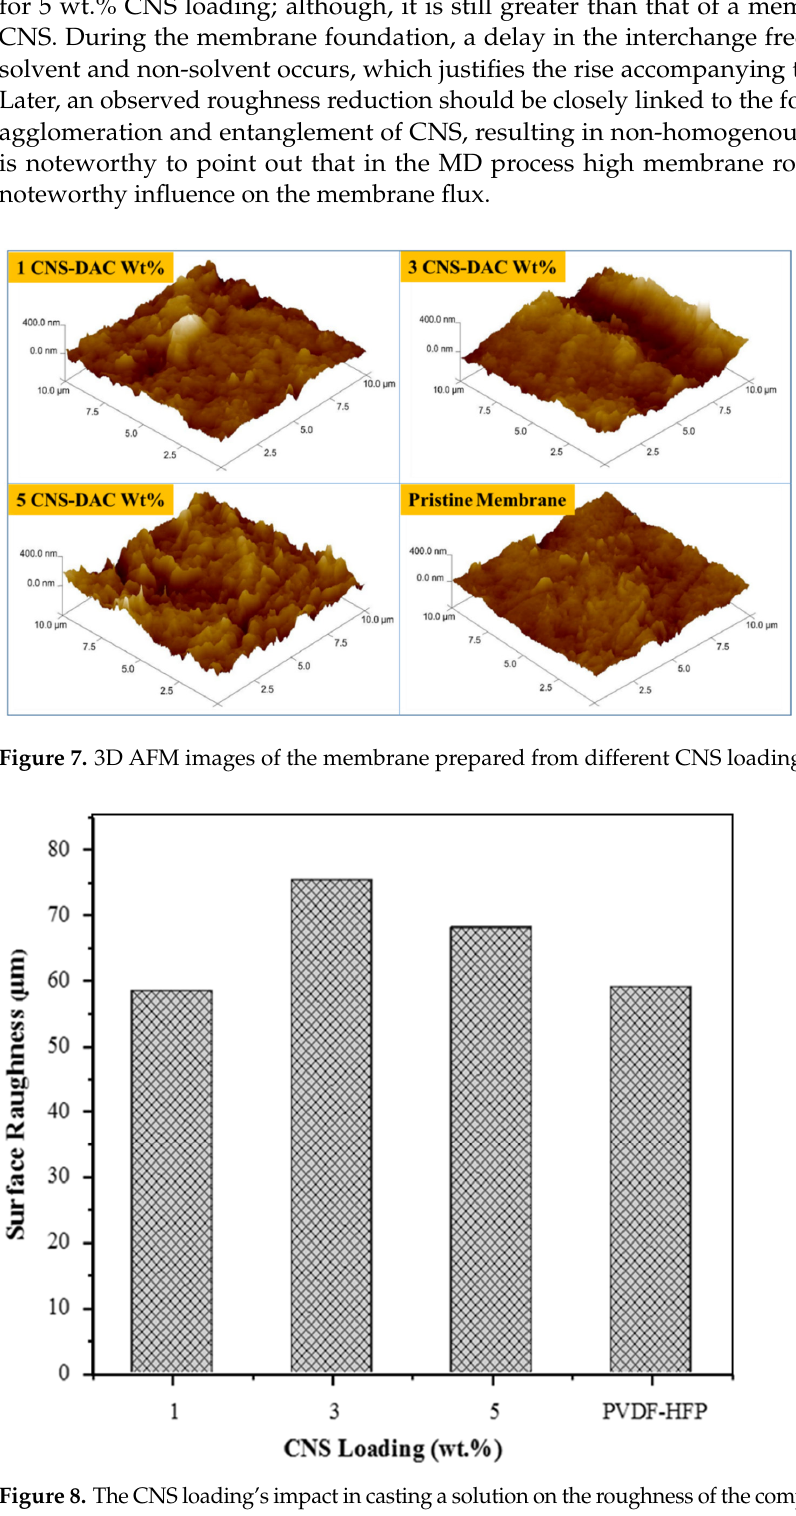
Figure 8. The CNS loading’s impact in casting a solution on the roughness of the composites’ mem-